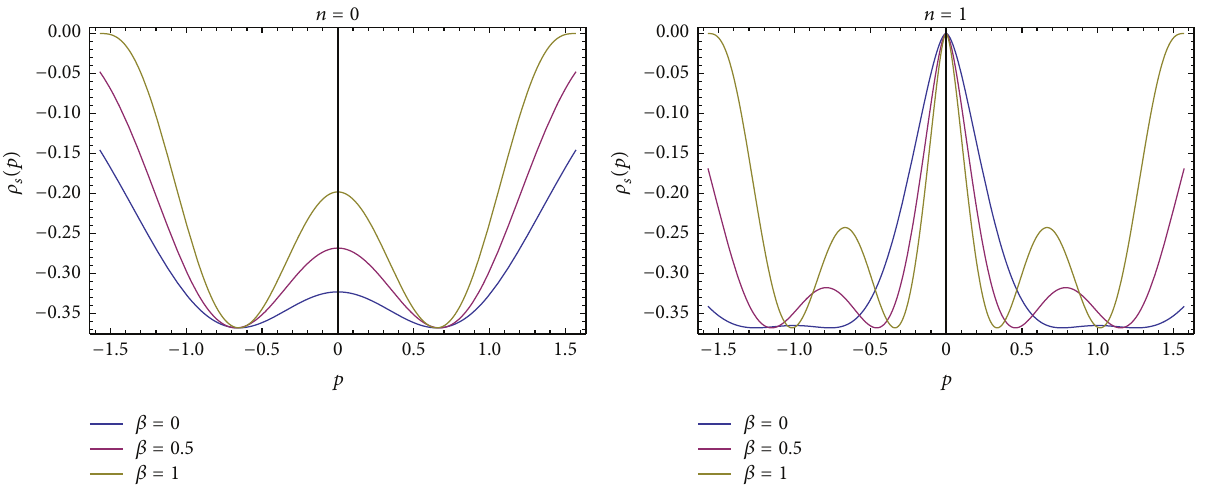
Figure 2: Plots of the momentum space entropy densities for 𝑚 = ℏ = 𝜔 = 1 and 𝑛 = 0, 1 .